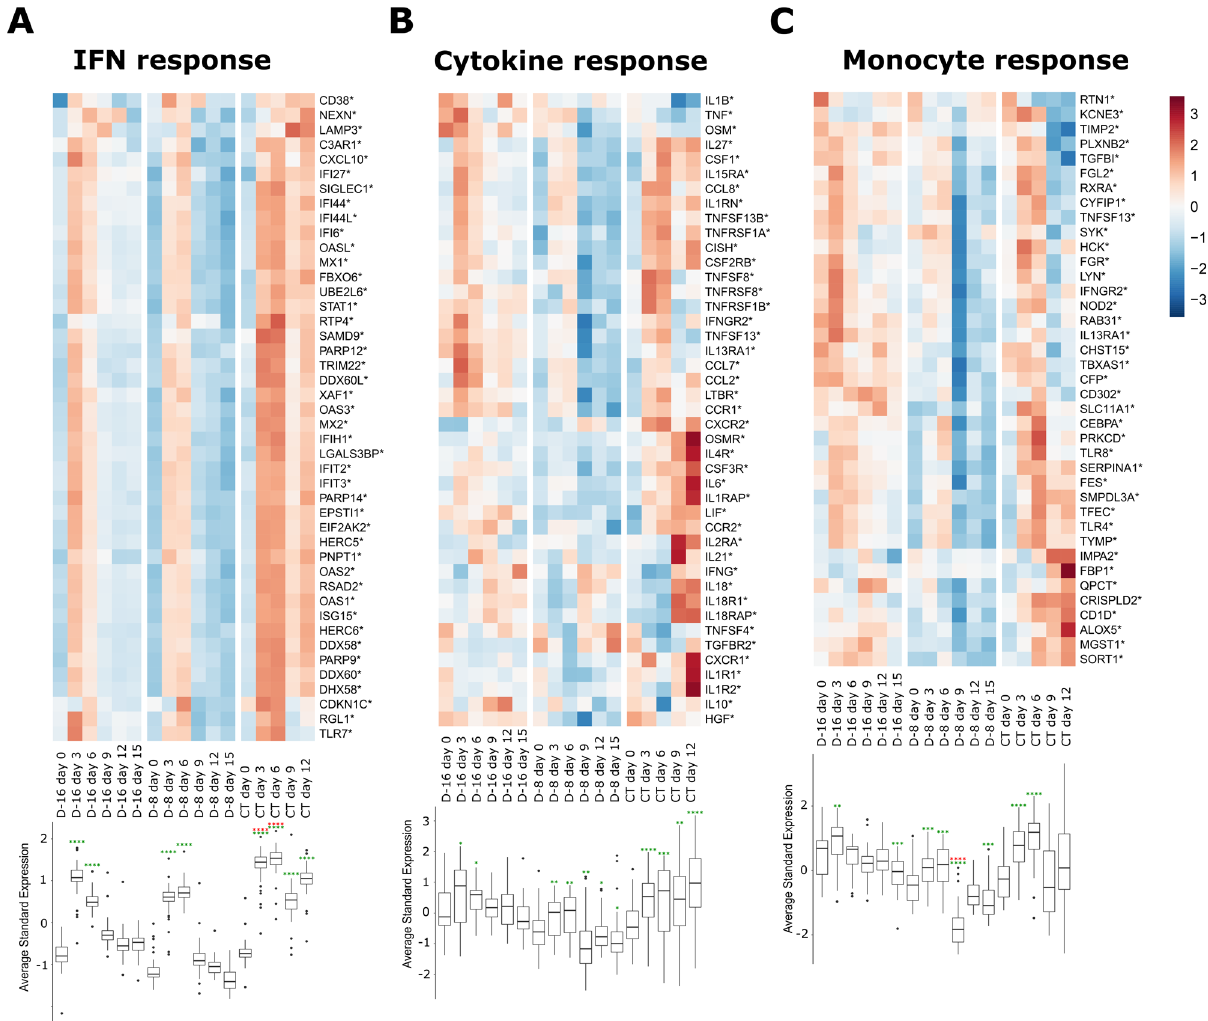
Fig. 8 | Evolution of the innate transcriptomic signatures in PBMC samples after LASV challenge over time. Gene expression heatmap of three gene sets: A antiviral response, B cytokine response, and C monocyte response. Each time point represents the mean of n =3 independent samples. The color of the cell representstheaveragestandardized(centeredandscaled)geneexpressionandthe intensity of standardized expression is given by the scale. Bottom: Boxplot repre- sentationofthestandardaverageexpression(Standardaver.expr.)ofthegenesfor each time point in the three gene sets (central line, median; hinges, fi rst and third